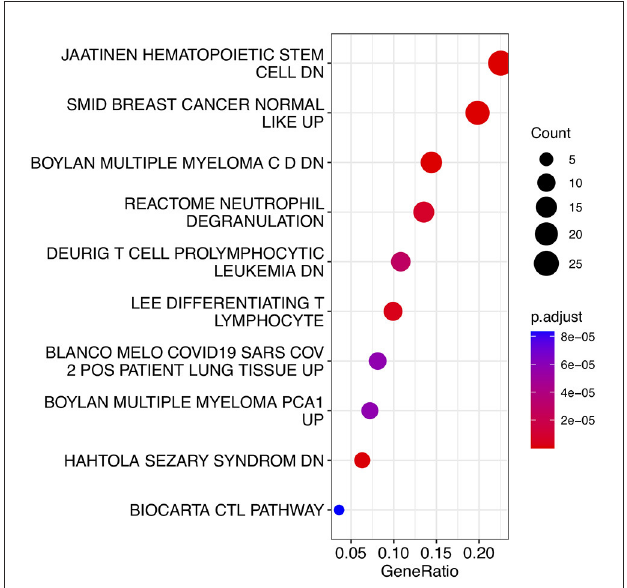
FIGURE5 Bubble diagram of KEGG pathways. Red and blue dots represent P values. KEGG, Kyoto Encyclopedia of Genes and Genomes.